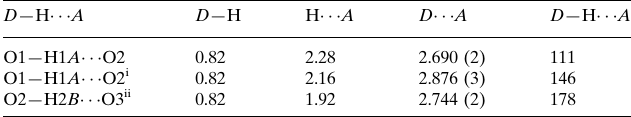
Hydrogen-bond geometry (A˚ , (cid:1)